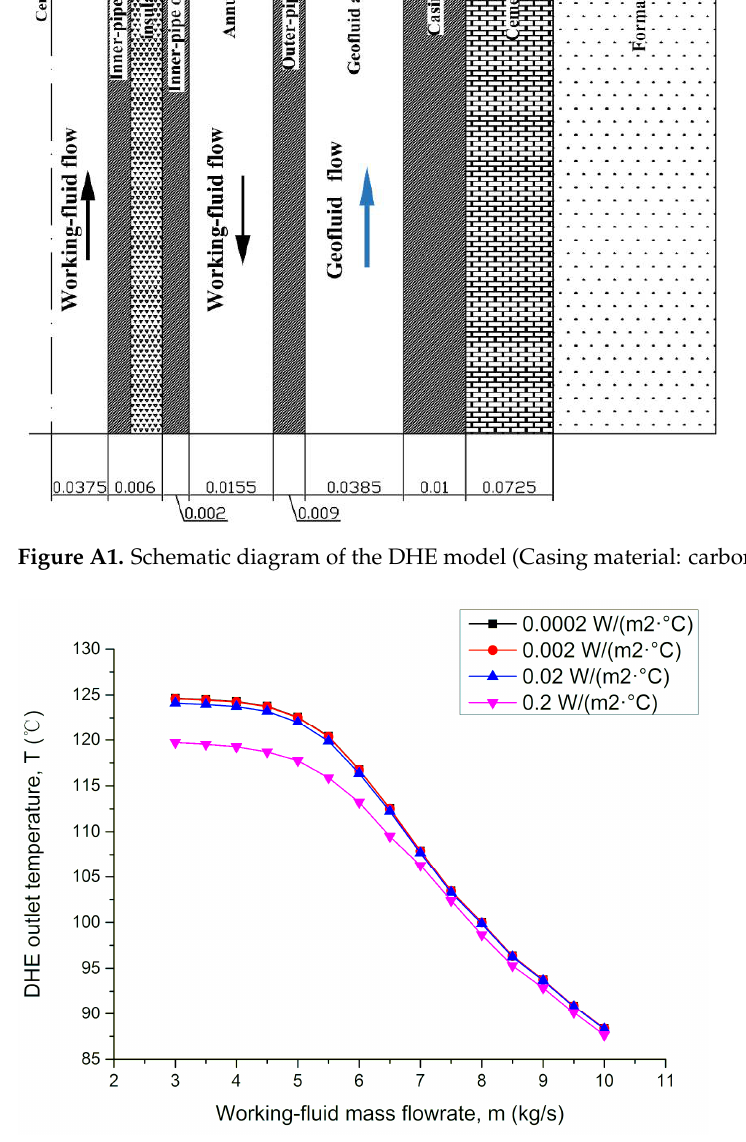
Figure A2. Comparison of power cycle’s net power output in terms of using different heat conduc- tivity of insulation layer (mixture ratio of working fluid = 0.5/0.5, geofluid mass flowrate = 5 kg/s, geofluid temperature = 130 °C, working-fluid’s DHE inlet pressure = 11 MPa, DHE length = 300 m). (b) Heat transfer between the annulus and geofluid